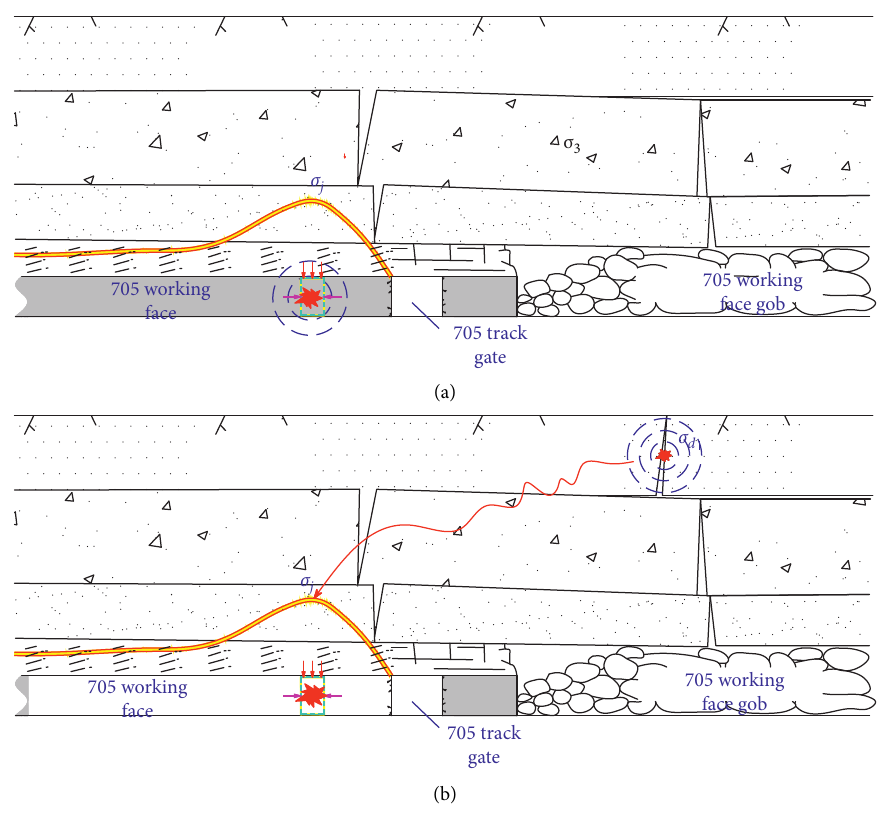
Figure 4: Typical rock burst in roadways: (a) pressure type; (b) impact type.